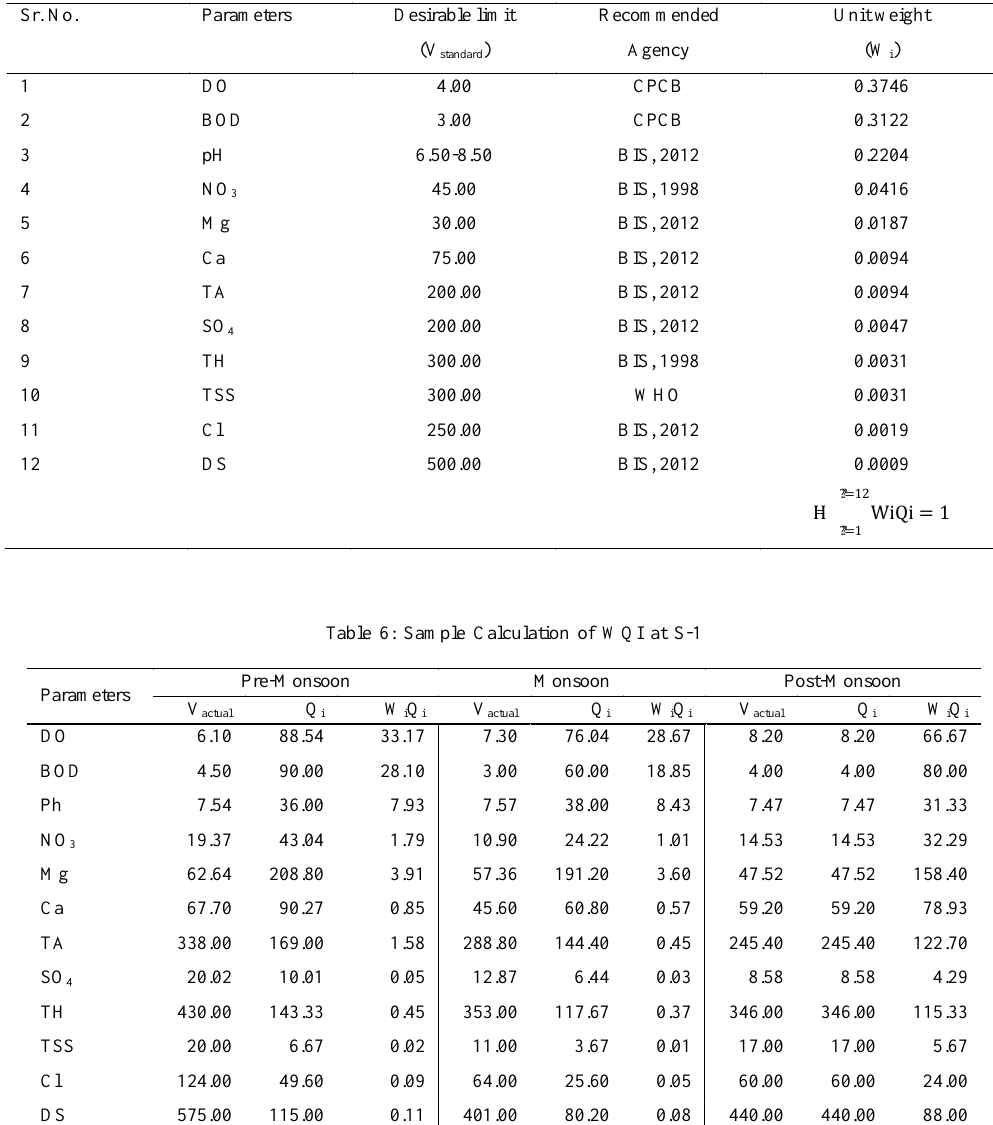
Table 5: Unit Weight of each parameter (Wi) used for Calculation of WQI